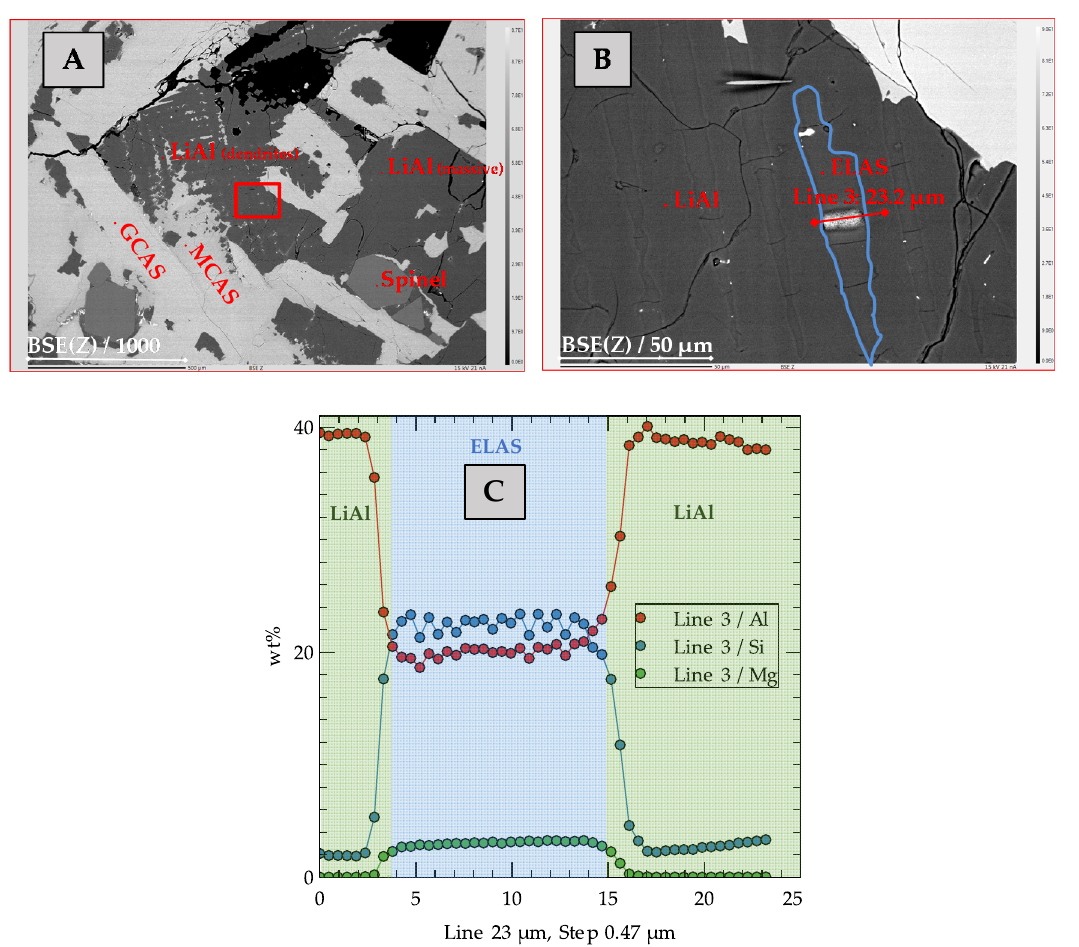
Figure 4. ( A ): Overview of the solidified melt (backscattered electron micrographs BSE(Z)). Medium grey grains, spinel; dark gray sections and dendrites, LiAl surrounded by Ca-alumosilicate (GCAS, MCAS, light grey sections); black, pores or preparation damage; red square, detail presented in ( B ). ( B ) Enlarged section from the red square in ( A ): the blue rim marks the grain of ELAS where the scan of Line 3 (red line) was measured. ( C ) Quantitative line scan of Line 3 (red line in ( B )).